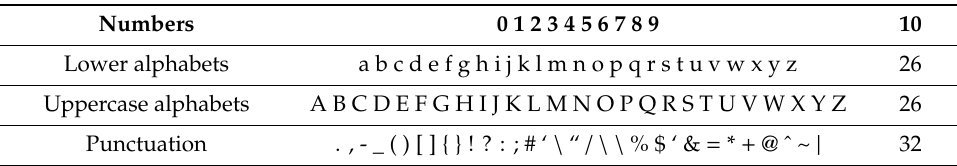
Table A3. Character set.